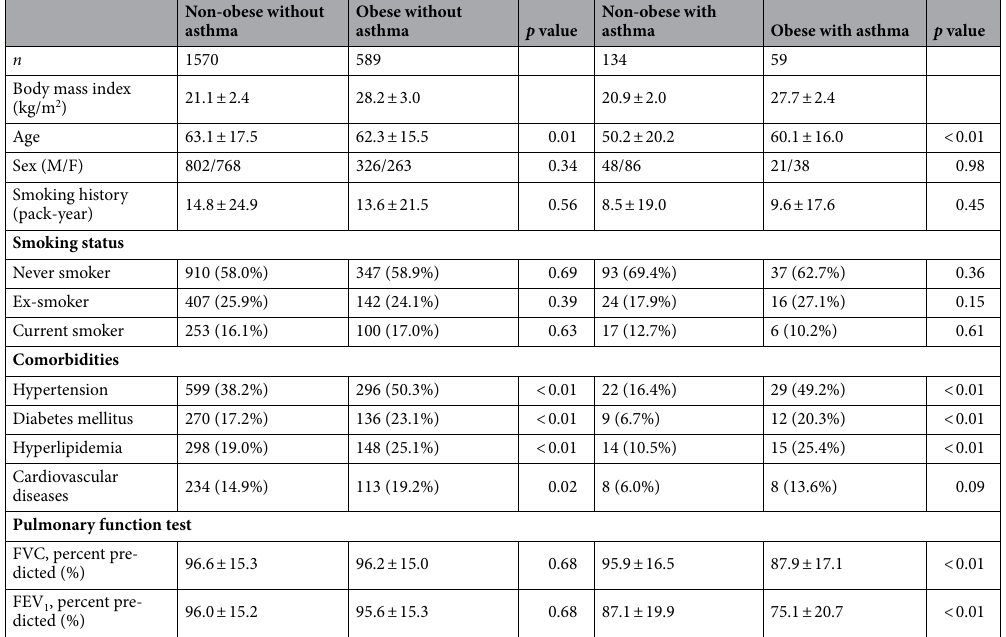
Table 3. Characteristics of patients with and without asthma associated with obesity. FVC, forced vital capacity; FEV 1 , forced expiratory volume in 1 s; CI, confidence interval.